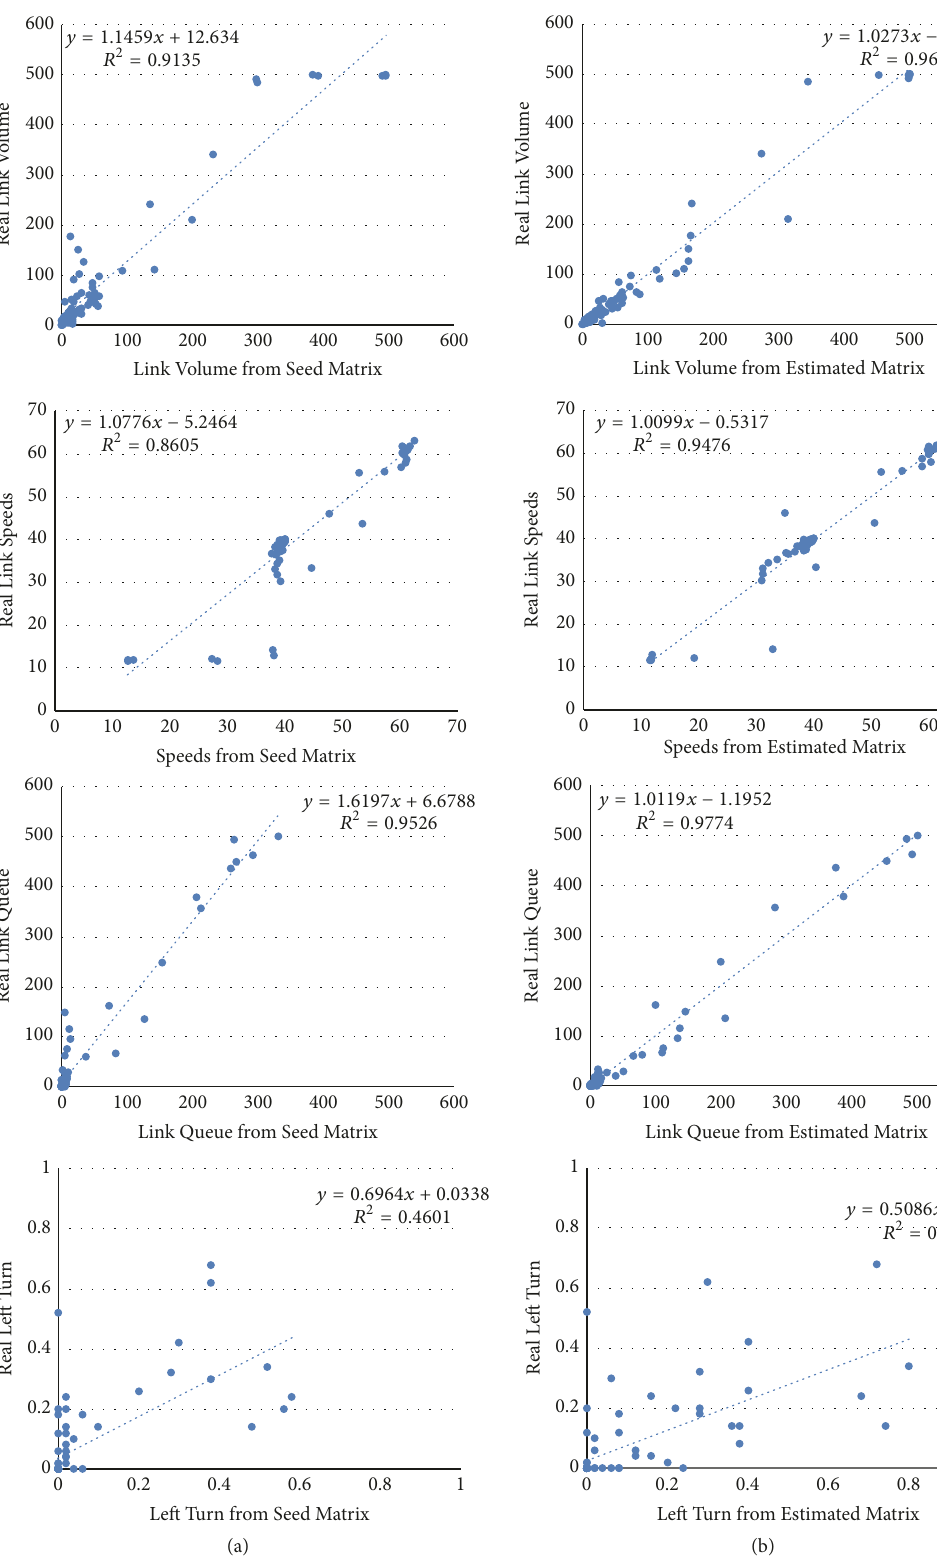
Figure 7: Scatter plots between traffic measures and simulated measures obtained from the seed matrix (a) and from the final estimated matrix